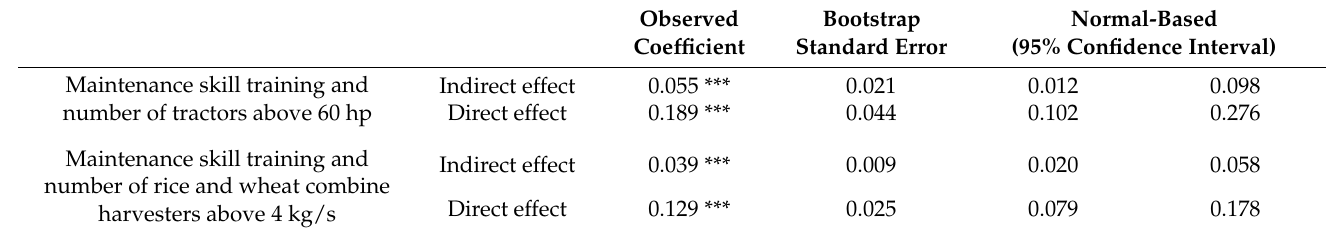
Table 9. Results of mediating effect test with Bootstrap